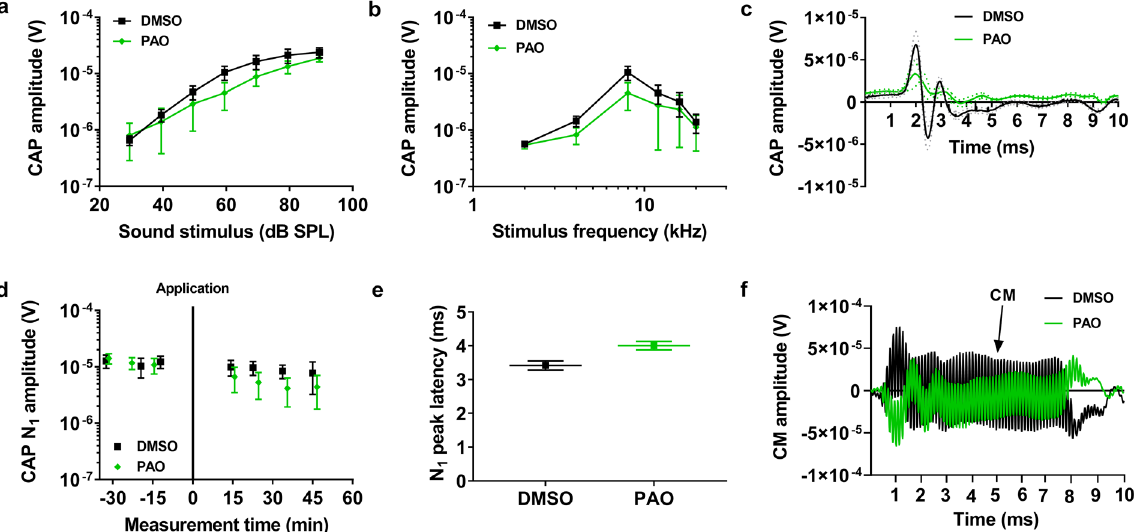
Fig. 8 PAO effect on hearing sensitivity, assessed by the compound action potential. a Schematic showing the CAP recordings for DMSO (black) and PAO (green) treated guinea pigs. b Average CAP amplitude to 60 dB SPL stimuli shows a slight reduction for the PAO animals compared to DMSO. c Grand averages ± s.e.m (dotted) of the CAP waveforms to 60 dB SPL stimuli shows little reduction in N1 and N2 amplitudes. d Averaged time courses of the changes seen in N1 amplitude measured at 60 dB SPL 8-kHz stimulus following PAO application, relative to DMSO application, which decreased non- signi fi cantly after 15 – 20 min of application. e Comparison of the CAP N1 latency after PAO application for animals in panel ( c ). f Representative waveforms of the CM potential, before and after 20 min of application of 1 mM PAO. The stimulus was 8-KHz tone burst at 90 dB SPL. The vertical line at time zero indicates the time of application. Data information: DMSO ( n = 10), PAO ( n = 6). Data are mean ± s.e.m. * P < 0.05; ns, not signi fi cant; two-way ANOVA